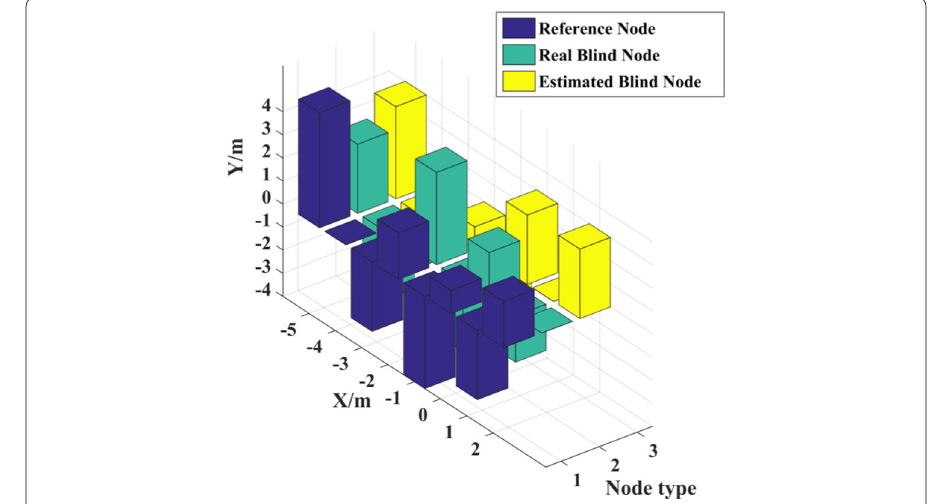
Fig. 7 Experiment 1 positioning error